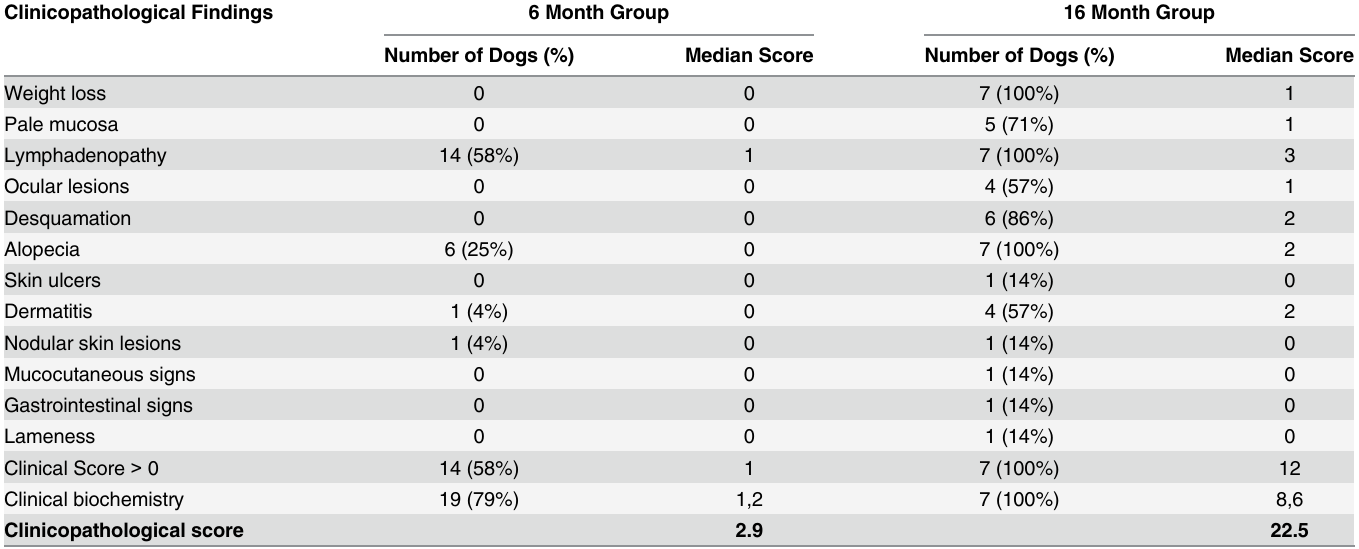
Table 1. Clinicopathological findings in experimentally infected dogs at 6 months and 16 months post-infection. Clinicopathological